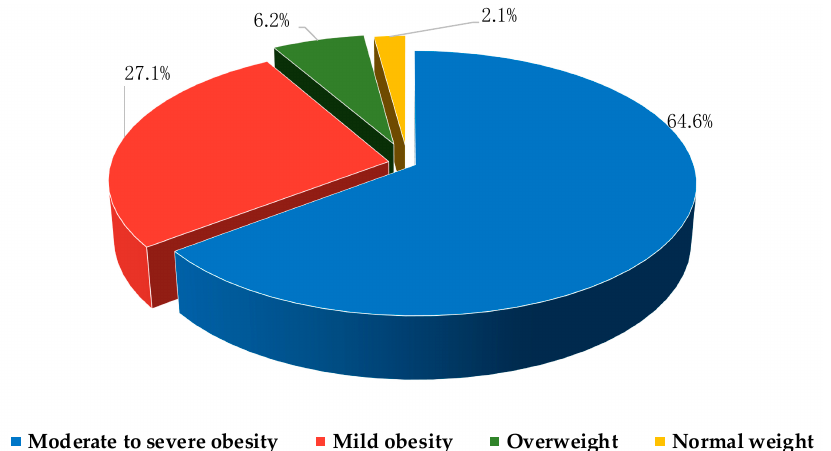
Figure 2. Baseline distribution of BMI classes of the study population: normal weight (BMI < 25 kg/m 2 ); overweight (25 < BMI < 30 kg/m 2 ); mild obesity (30 < BMI < 35 kg/m 2 ); moderate-to-severe obesity (BMI ≥ 35 kg/m 2 ).